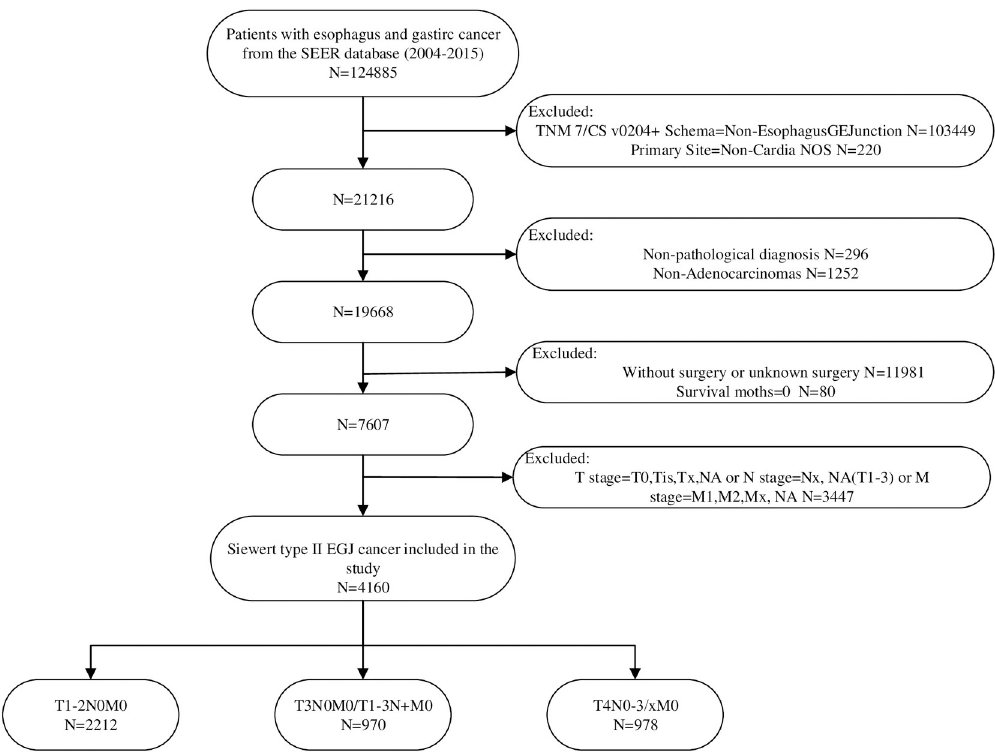
Fig 1. Inclusion and exclusion procedures for Siewert type II EGA patients from SEER